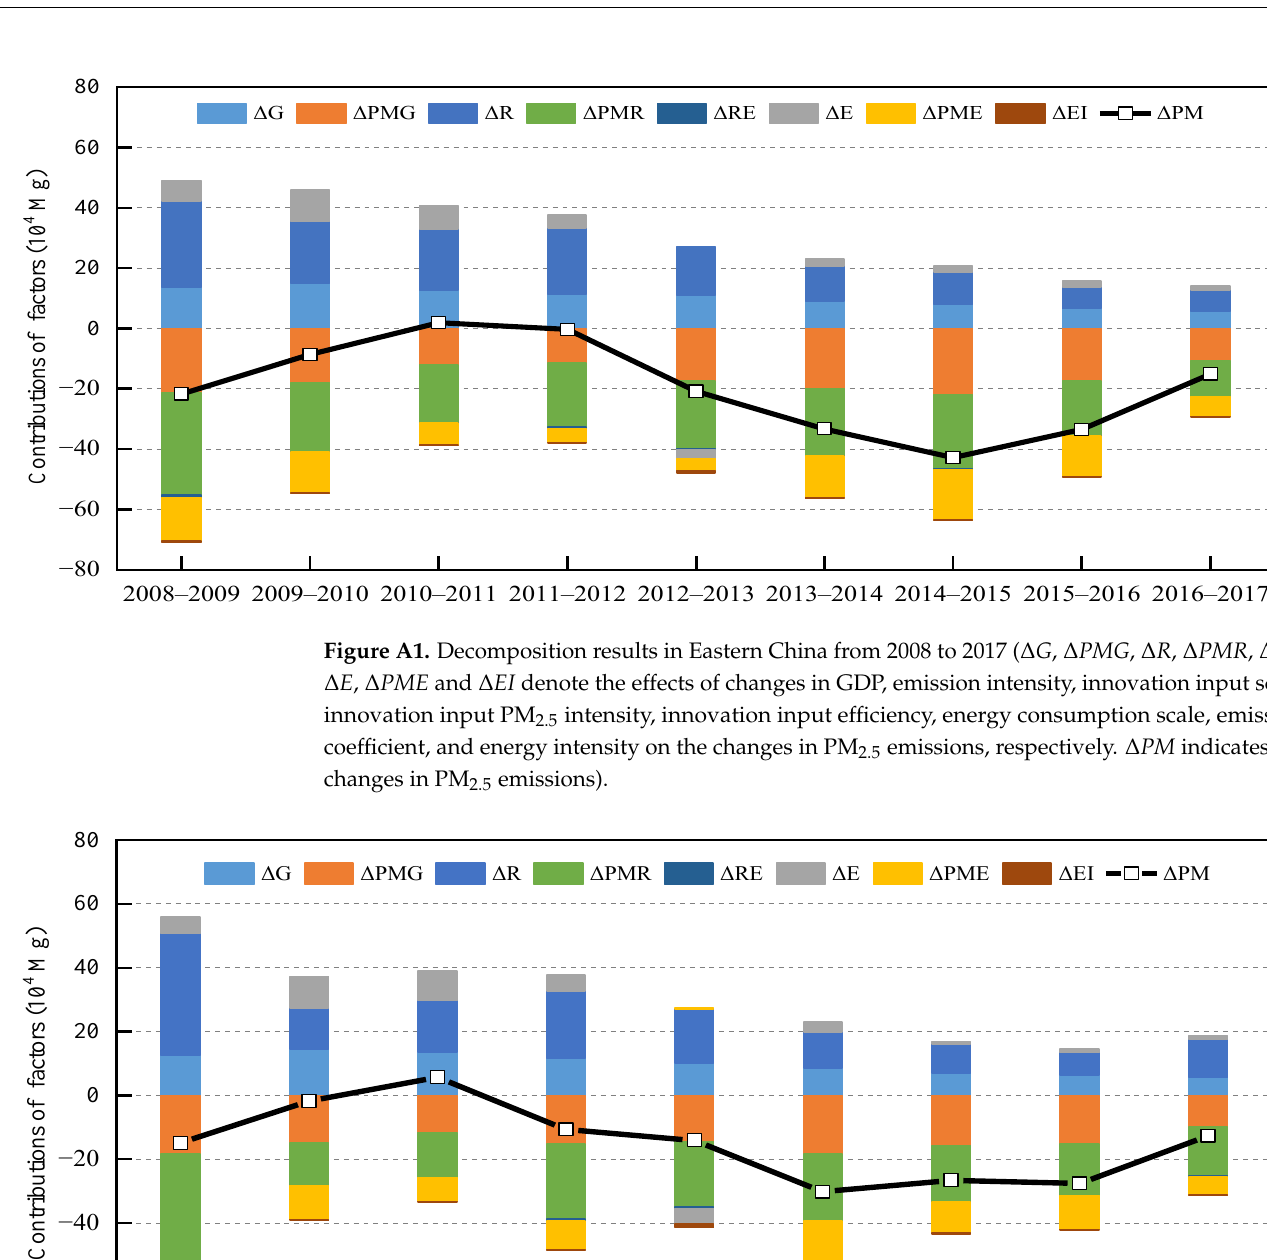
Figure A3. Decomposition results in Western China from 2008 to 2017 ( Δ G , Δ PMG , Δ R , Δ PMR , Δ RE , Δ E , ΔP ME and Δ EI denote the effects of changes in GDP, emission intensity, innovation input scale, innovation input PM 2.5 intensity, innovation input efficiency, energy consumption scale, emission coefficient, and energy intensity on the changes in PM 2.5 emissions, respectively. Δ PM indicates the changes in PM 2.5 emissions).